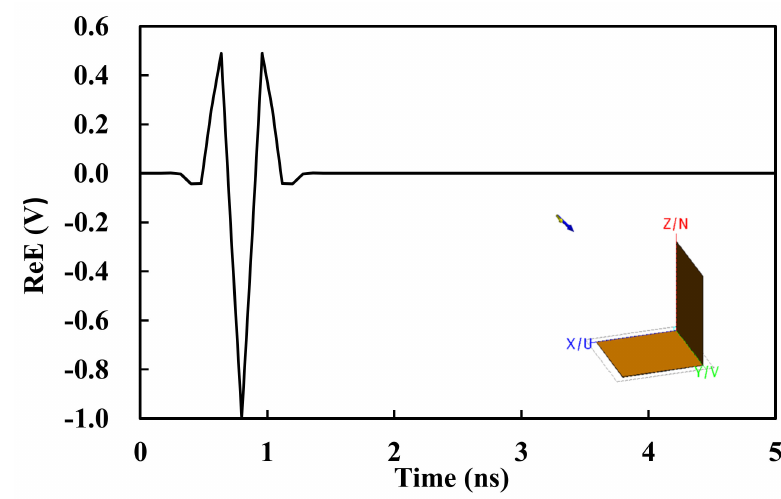
Figure 12. Time − domain waveform of incident pulse.